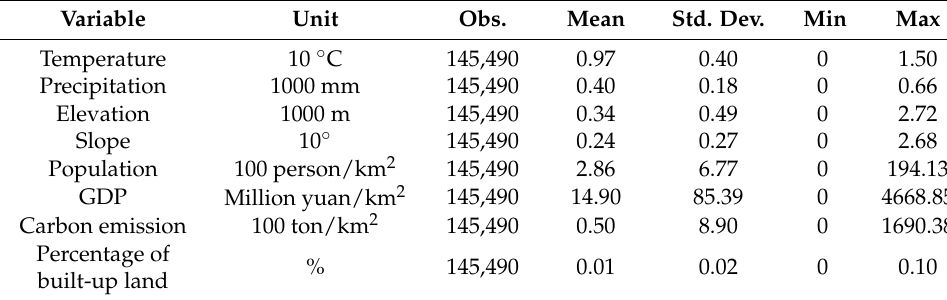
Table 1. Descriptive statistics of resilience impact